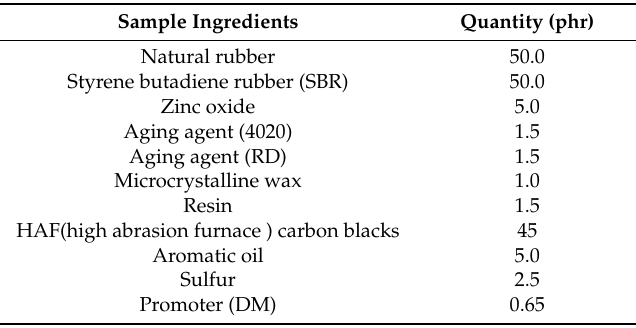
Table 1. Composition of SBR/NR hybrid vulcanized rubber used in this study.